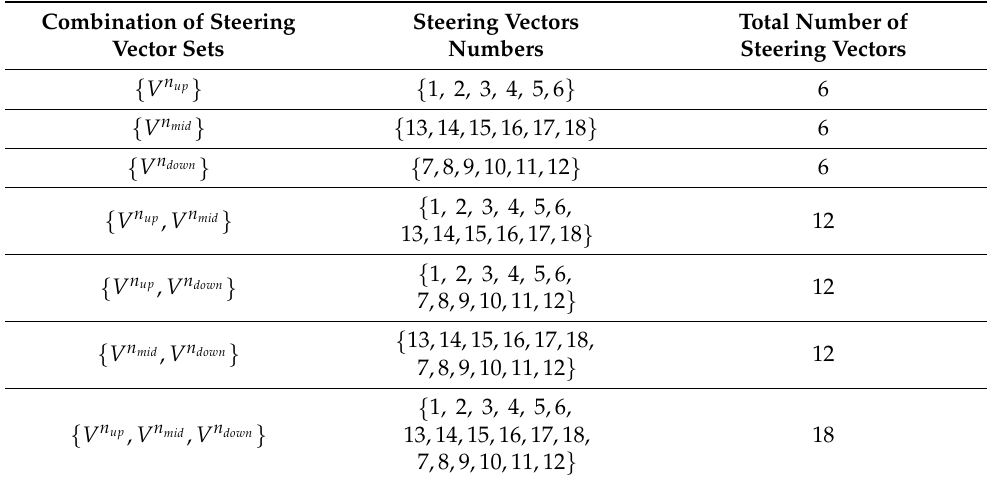
Table 3. Combinations of steering vector sets used in verification of DoA estimation performance using generalized PPCC-MCP algorithm (see text for